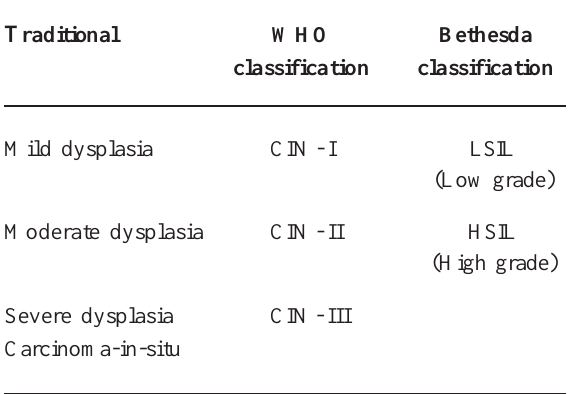
Table 2. Different categorizations of cervical